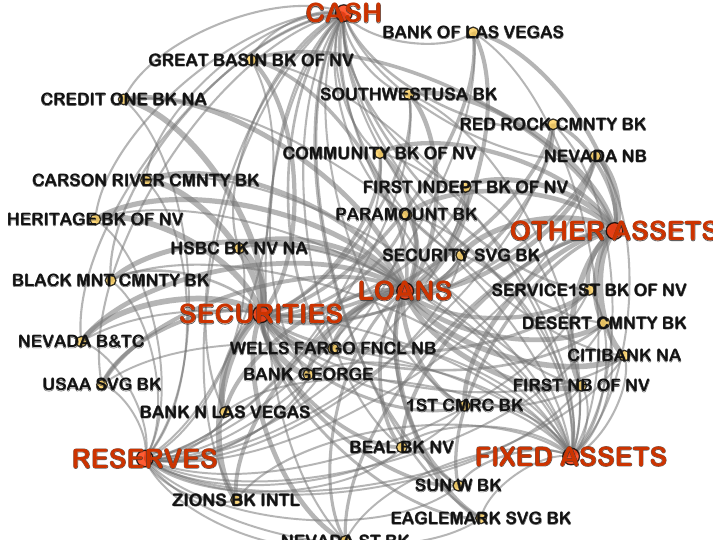
Figure 3. The bilateral bank–asset networks of IL (the top one) and NV (the bottom one) states. The big yellow nodes represent banks, the small orange nodes represent the six types of assets, and the thickness of each edge is proportional to its weight.